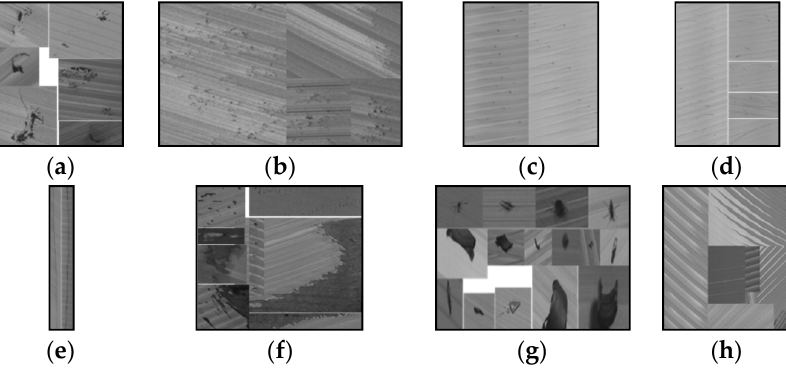
Figure 3. Samples of different defects: ( a ) Slag inclusion (SI); ( b ) Pitted slag inclusion (PSI); ( c ) Adhesion aluminum (AA); ( d ) Scratches (Sc); ( e ) Crack (Cr); ( f ) Oxide film (OF); ( g ) Mosquito (Mo) and aluminum chips (AC); ( h ) Texture background (Tb).